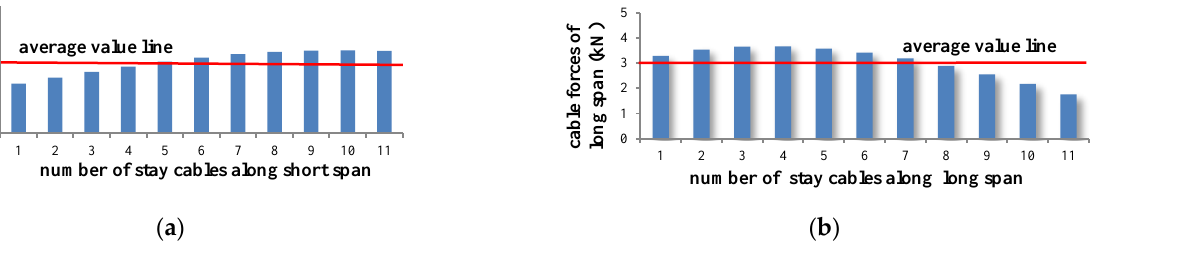
Figure 2. Cable forces obtained by FEM. ( a ) Cable forces of short span; ( b ) Cable forces of long span.